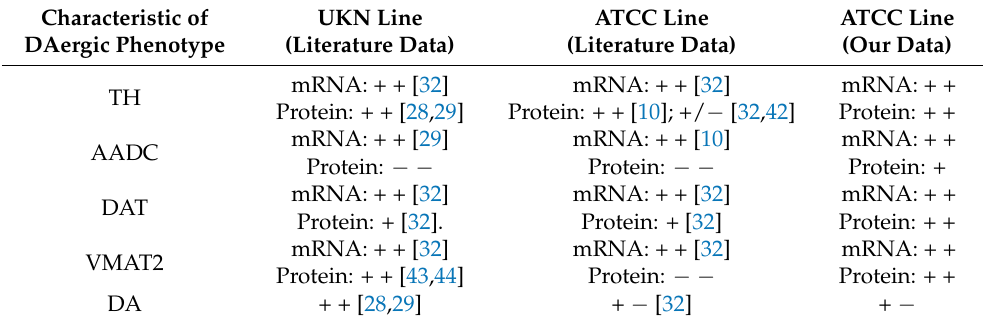
Table 1. Main characteristics of the dopaminergic phenotype of differentiated LUHMES cells, UKN and ATCC cell lines, according to the previous and this